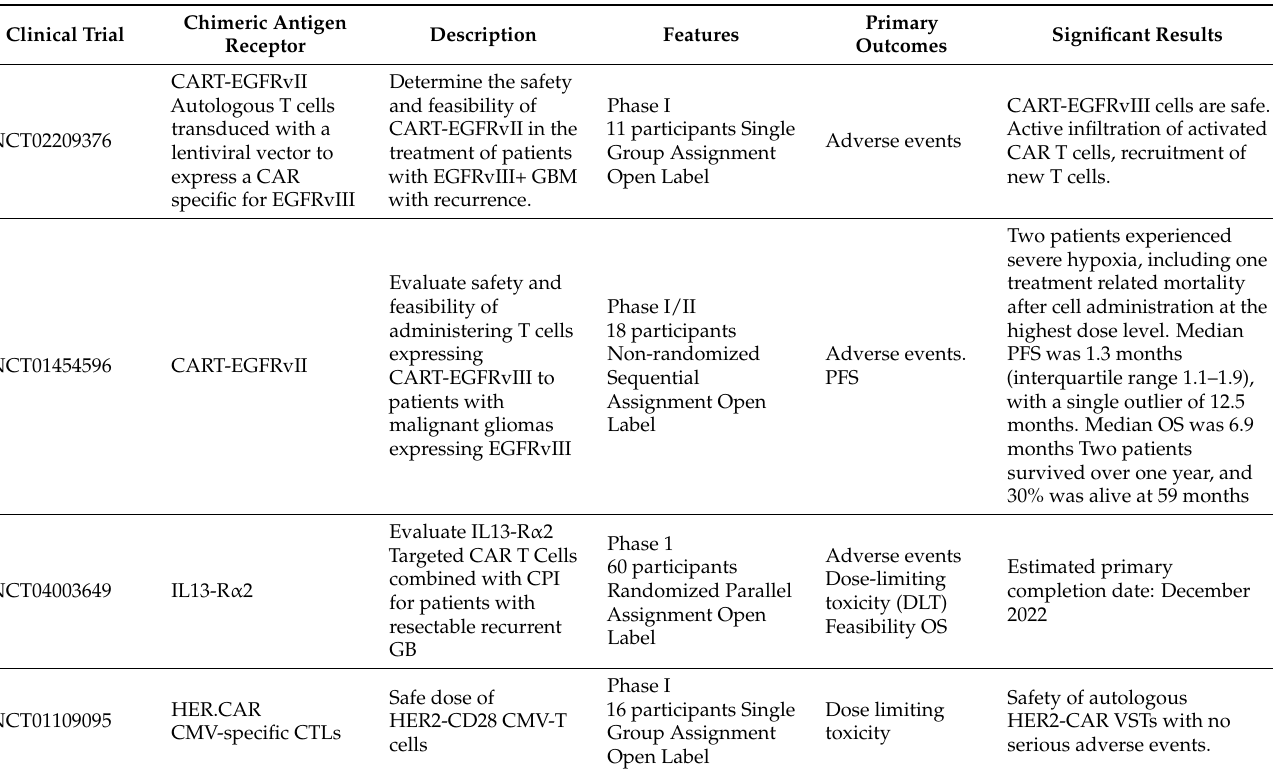
Table 4. Chimeric Antigen Receptor (CAR) T Cell